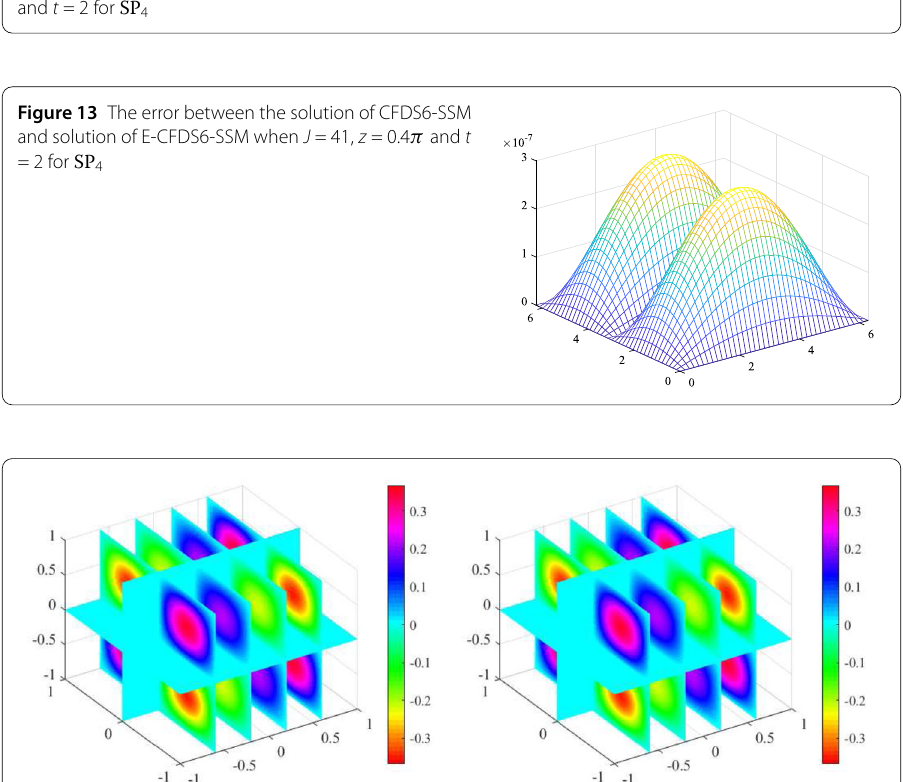
Figure 14 The numerical solution of CFDS6-SSM (left-hand side) and E-CFDS6-SSM (right-hand side) when J = 41 and t = 1 for SP